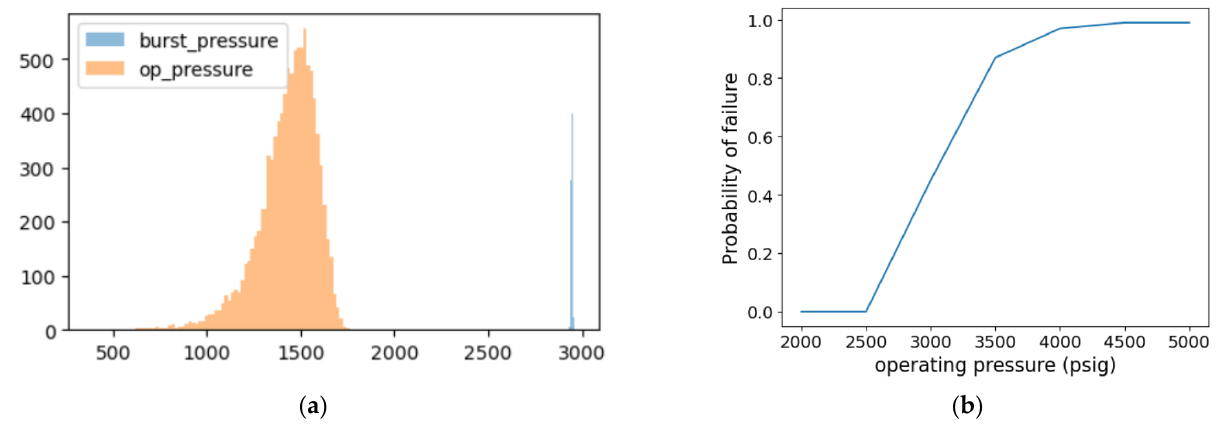
11 of 14 ( b ) Figure 8. Corrosion Growth Rate (CGR): ( a ) short-term CGR (in mm) by GWNUM; ( b ) long-term CGR (in mm) by GWNUM. 3.4. Remnant Life Analysis In this part, the burst pressure of the pipeline for individual defects was calculated as per ASME B31G code Equations (1) and (2). Figure 9a depicts the distribution of burst pressure for all datasets, which is a deterministic method, with the mean value at 2937 psig. For the probabilistic MCS, uncertainties were considered to estimate the PoF when the pipeline operating pressure exceeded the burst pressure of the corroded pipeline. Running an MCS involves two components: the equation for evaluation and random variables for the input. Random variables were generated and burst pressure was calculated again using Equations (1) and (2). Figure 9b summarises the PoF for a different operating pressure. The pipeline parameters were unavailable in the original dataset; therefore, the user- defined values were obtained from the literature [18] as per Table 4 below. Table 4. Probabilistic models of the random variables [18].